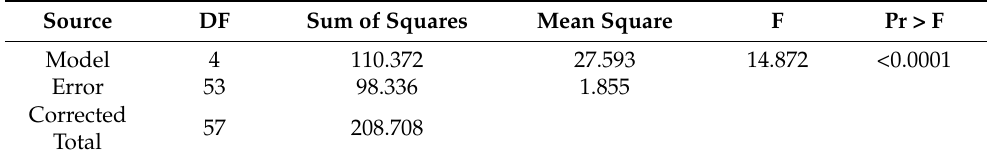
Table 4. F-test for regression model